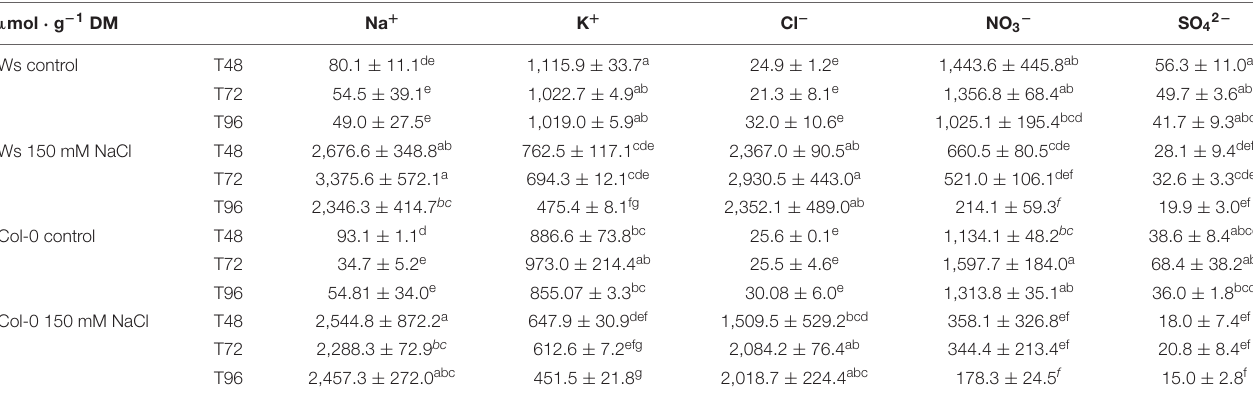
TABLE 1 | Elemental composition (Na + , K + , Cl − , NO 3 − , and SO 42 − ) ( µ mol · g − 1 DM) of the shoots of Ws and Col-0 plants grown under control conditions or 150 mM NaCl during T48, T72, and